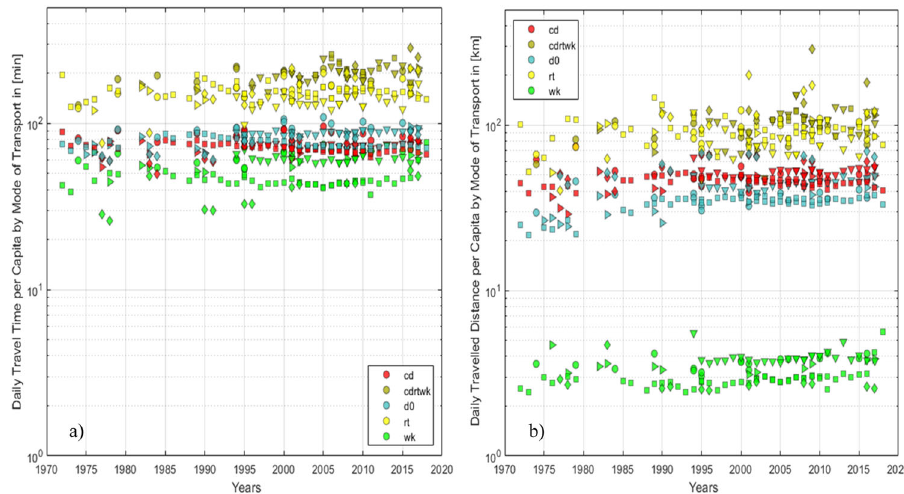
Fig. 7 A comparison of daily travel time and travel distance. Average daily travel time a and distance b per capita over years on a semi-logarithmic scale of walking (wk), car driver (cd), rail train (rt), the modal combination of car-driver, walking and rail, and the standard average daily travel time, without modal distinctions ( d 0), representing the travel time budget